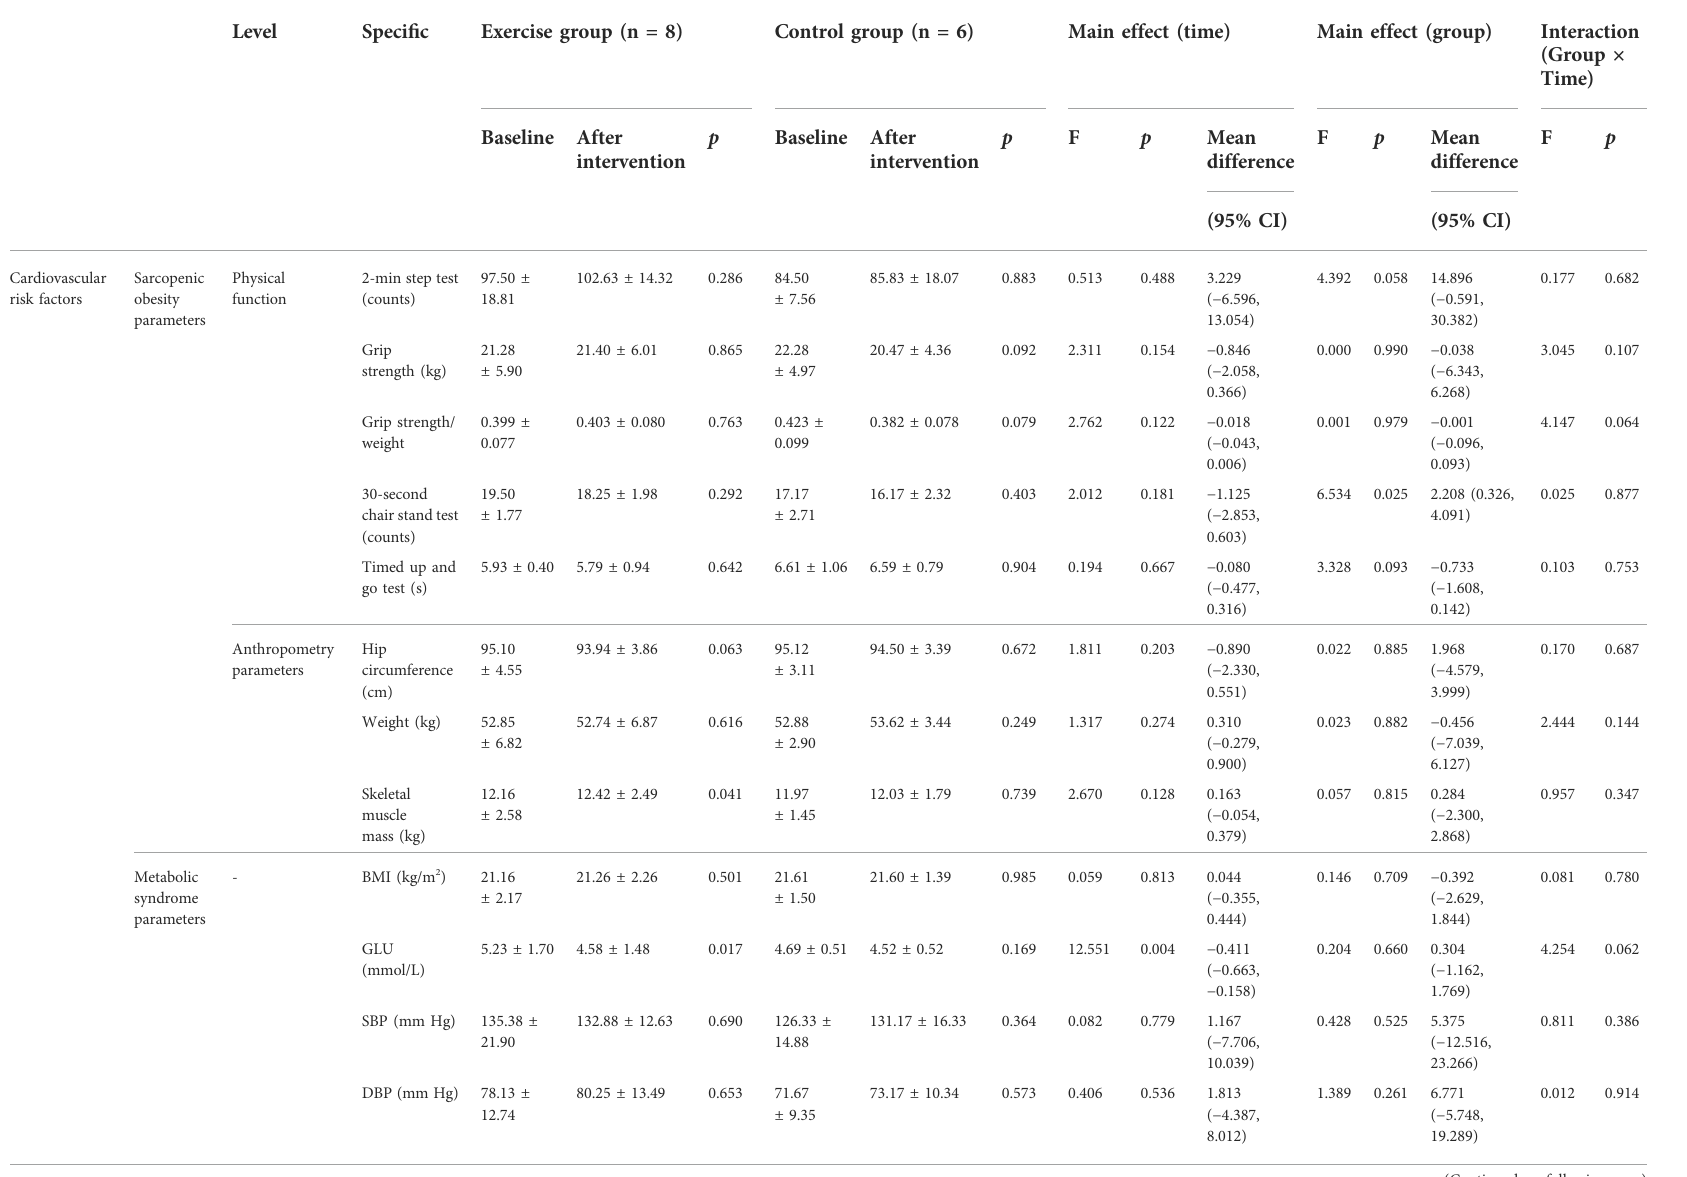
TABLE 3 Changes in cardiovascular risk factors in each group following the